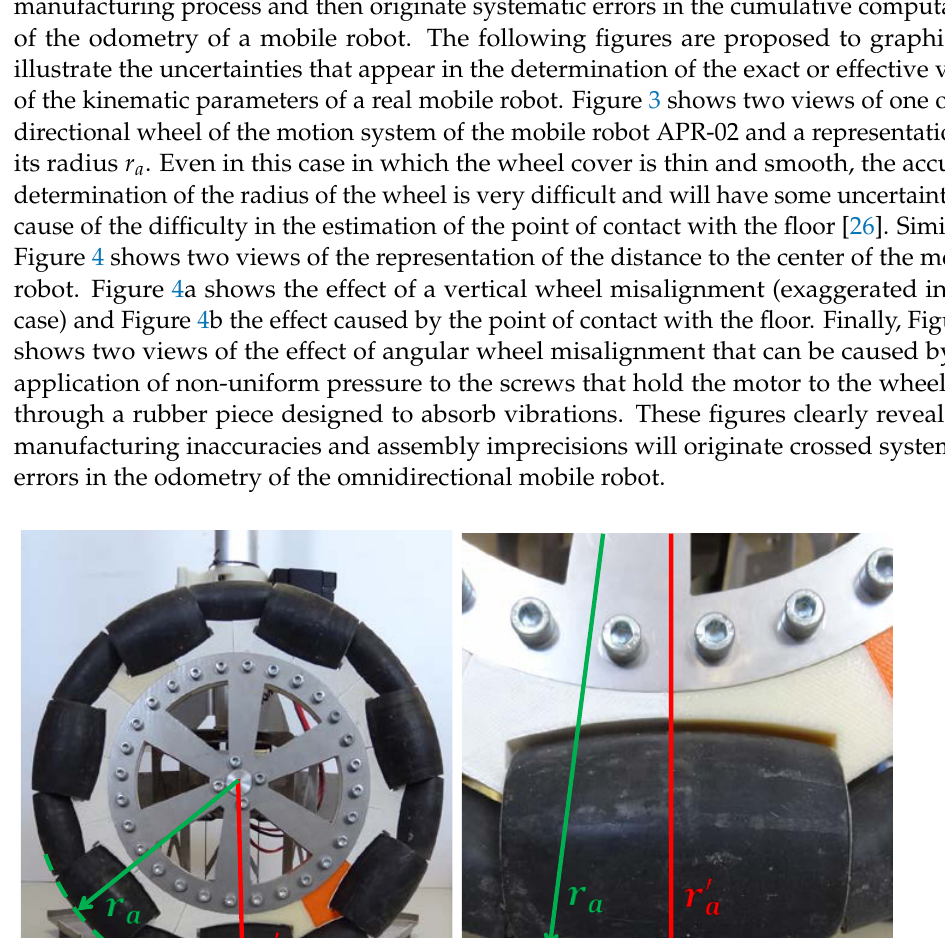
the real or effective 𝑀𝑀′ 𝑟𝑟